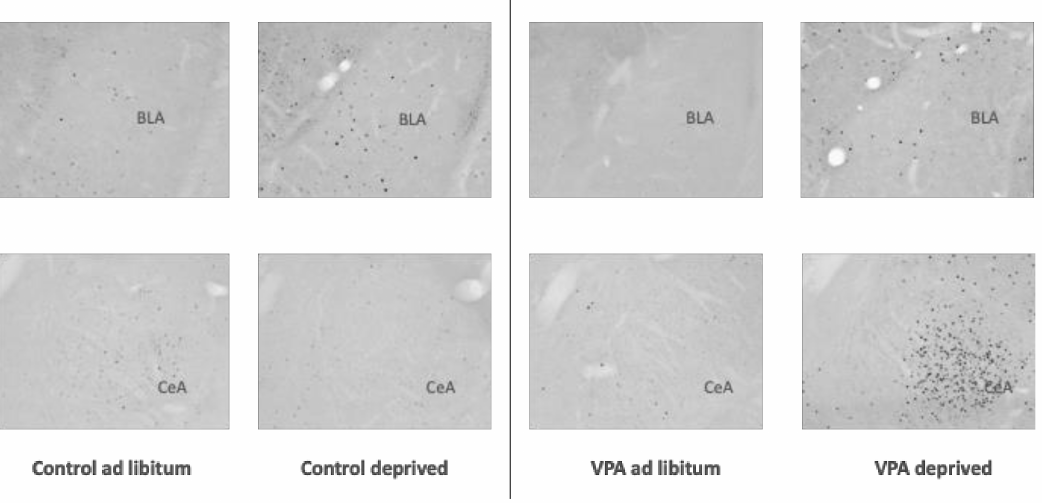
Figure 8. Photomicrographs depicting c-Fos IR in the amygdala. BLA—basolateral amygdala, CeA—Central nucleus of the